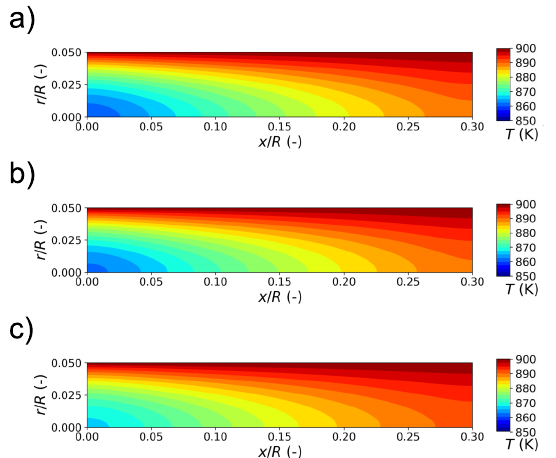
Figure 4. The temperature distribution for different biogas compositions (uniform catalyst